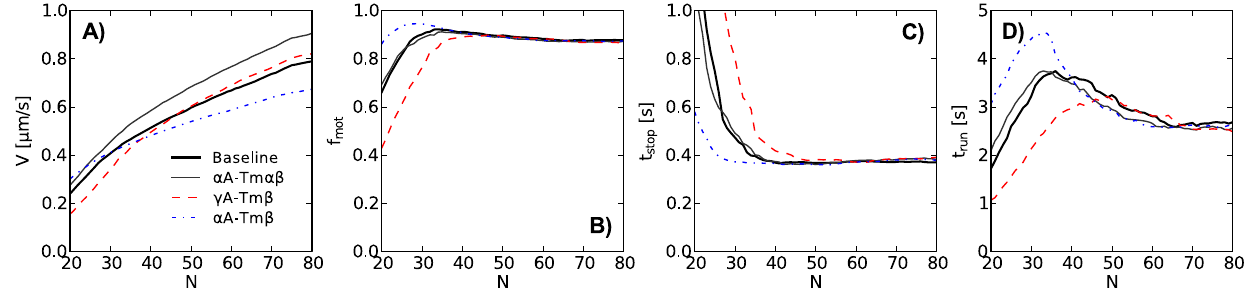
Figure 5. Simulated invitro actin sliding features. A–D) Actin sliding features plotted vs. filament length. Motility features were extracted from simulated actin sliding in the same way as from the experimental data (Fig. 2).